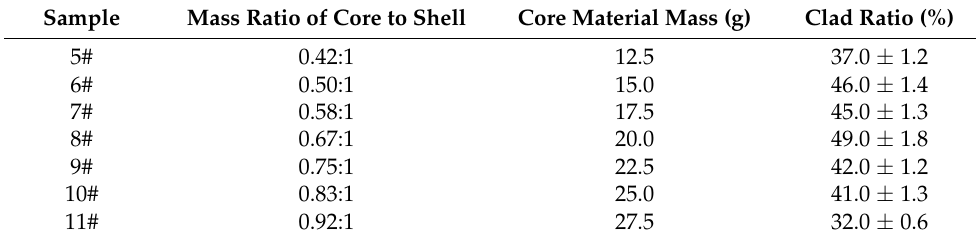
Table 9. Clad ratio results of microcapsules by the single factor